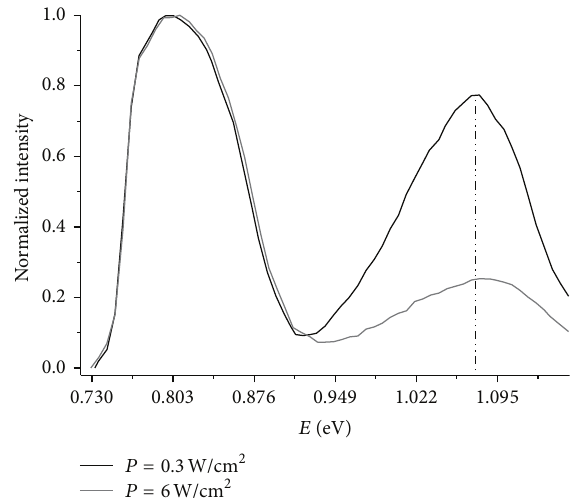
Figure 5: PL spectra at 20 K obtained for different excitation powers = 1064 nm) on the as-grown CZTS samples after the etching ( 𝜆 exc procedure in aqueous